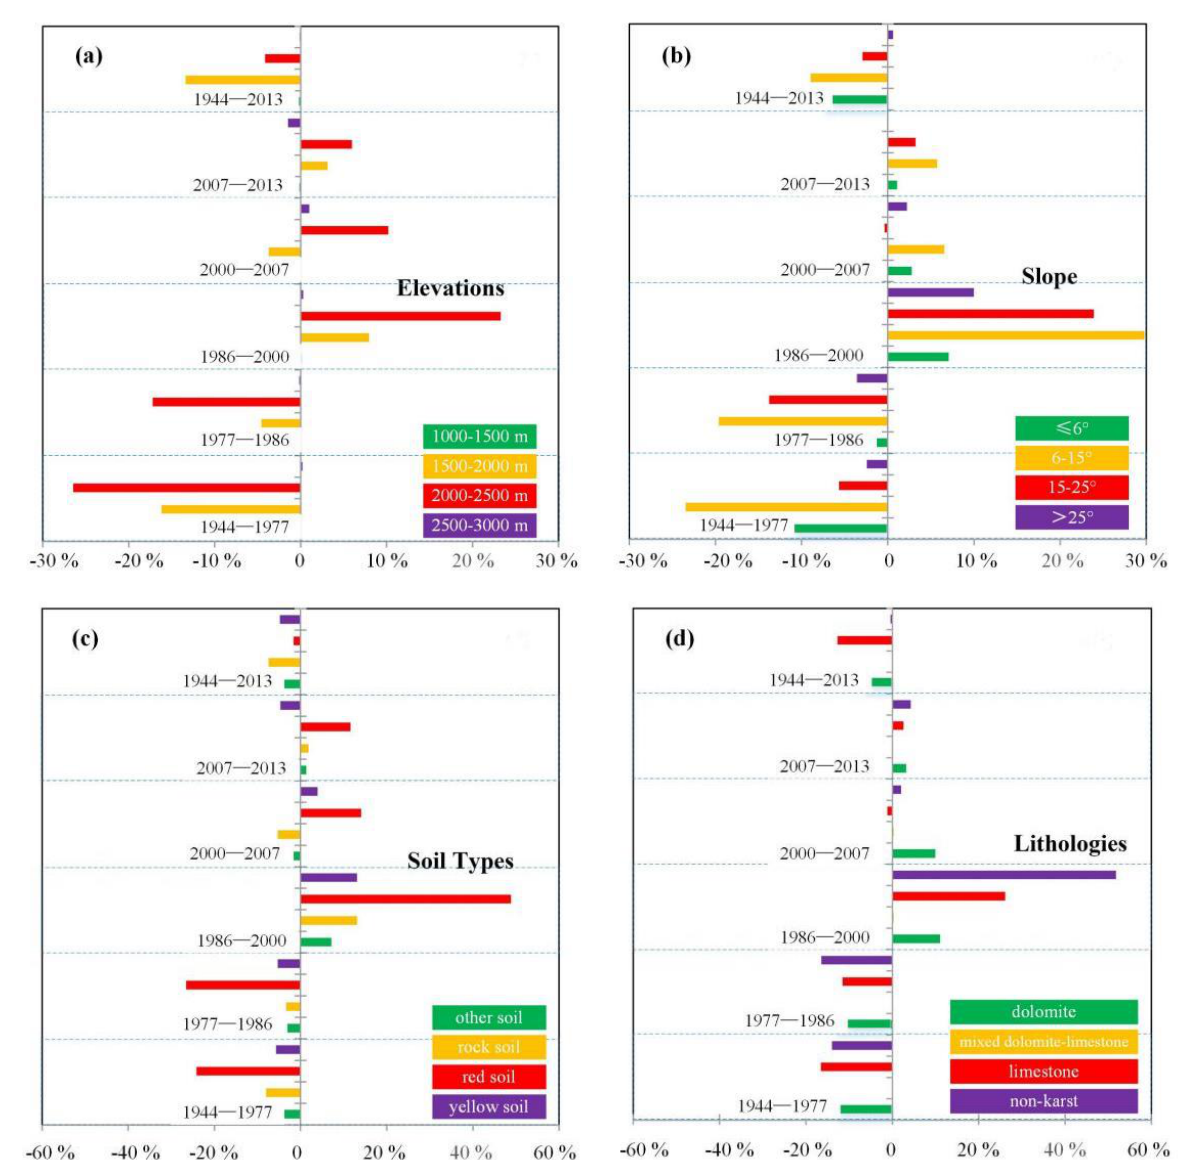
Figure 7. The percentage of forests changing area with different elements grades in the total forest area in different historical periods. (We constructed this figure using WPS office (https://platform.wps.cn/) (accessed on 27 December 2021))